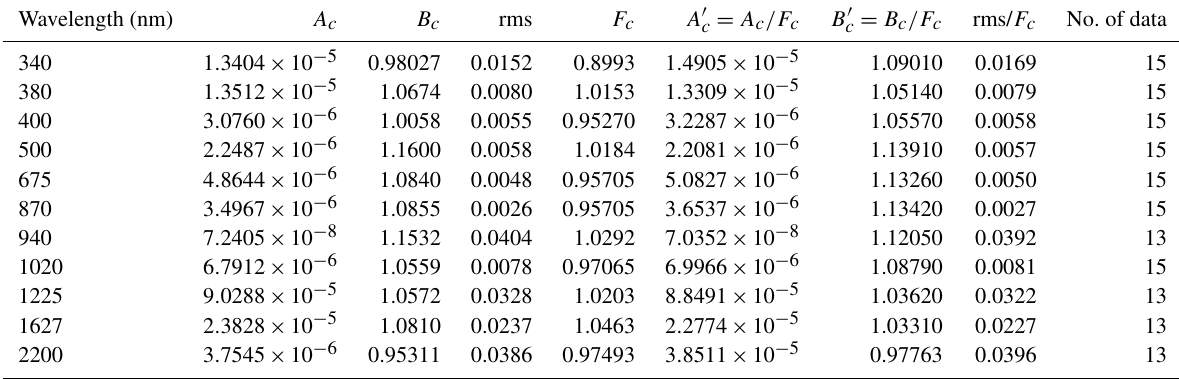
Table 3. Coefficients of the regression equation for reflectance correction factor C . Wavelength